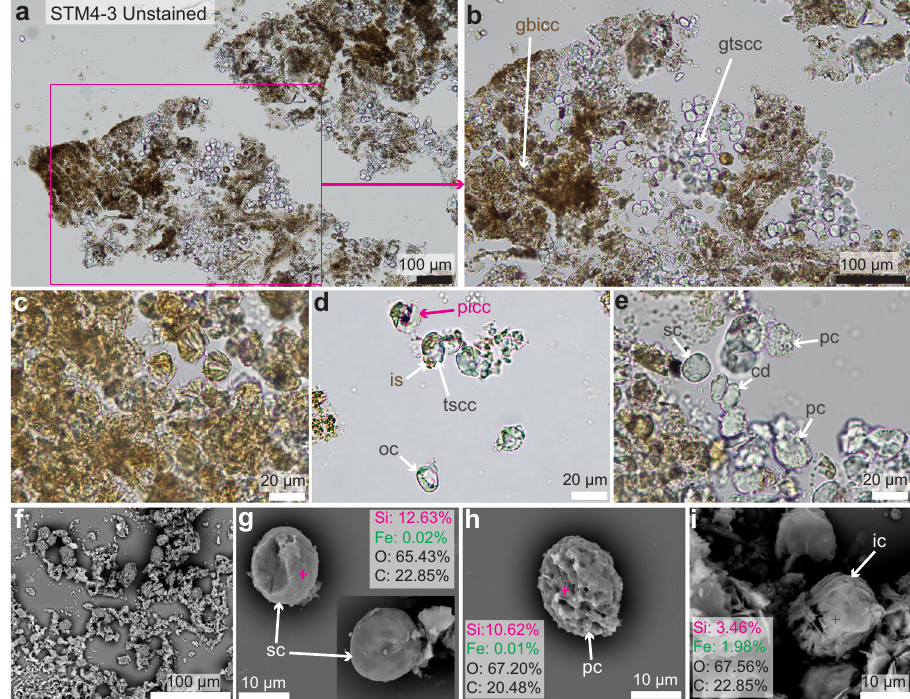
Fig. 3 Photographs of unstained paraf fi n sections and SEM images of the demineralized cartilage of STM4-3. a One example of a 10 µ m thick paraf fi n section of unstained, demineralized cartilage shows a dark brown material overall. b A close-up on this material shows that it is made of numerous globular structures representing fossilized chondrocytes. Some of them are transparent, others are brown. They represent alumino-silici fi ed cells and ironized cells respectively. c Close-up on brown, ironized cartilage cells showing some striations. d Close-up on some ironized cells showing an iron sheath (is) that is peeling off. Other cells are apparently open (oc, open cell) and some show potential intracellular content (picc). e Close-up on transparent silici fi ed cells showing two types of cells (smooth cells, sc; and porous cells, pc). f SEM image of a slide of demineralized cartilage sprayed with gold. g SEM image of two smooth silici fi ed cells paired with an EDS analysis at the pink cross. h SEM-EDS image of a porous silici fi ed cell. i SEM-EDS image of a striated ironized cell. Additional abbreviations: cd, cell doublet; gbicc, group of brown ironized cartilage cells; gtscc, group of transparent silici fi ed cartilage cells; tscc, transparent silici fi ed cartilage